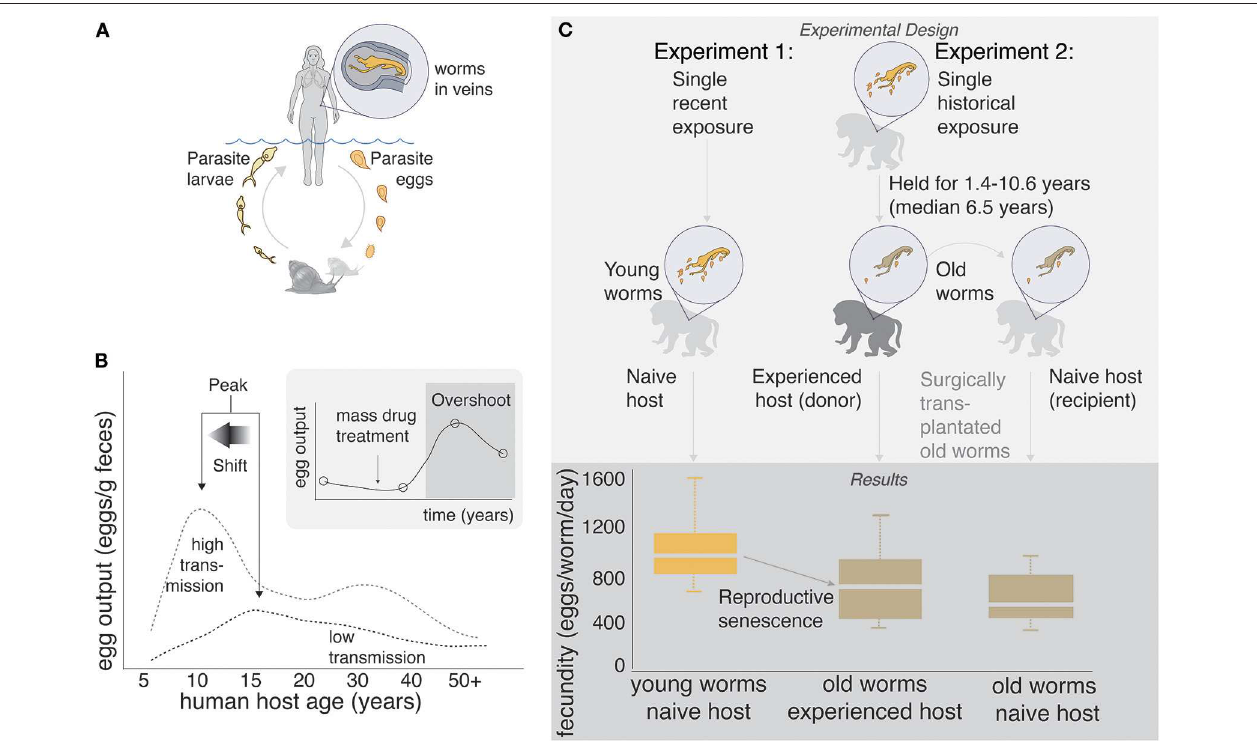
FIGURE 1 | (A) Human schistosome life cycle. (B) Classic age-intensity curve showing the epidemiological concepts of peak and peak shift. Data are taken from a study in China (8), but similar patterns have been shown in many endemic areas of Africa, Asia, and the Americas. Inset: “Overshoot” is sometimes observed after mass drug administration in areas of high transmission. Data are taken from a study in Senegal (9), but the pattern has been observed in many other areas. (C) Experimental evidence of senescence of fecundity in old (1.4–10.6 years) schistosome worms infecting non-human primates. Senescence of fecundity is